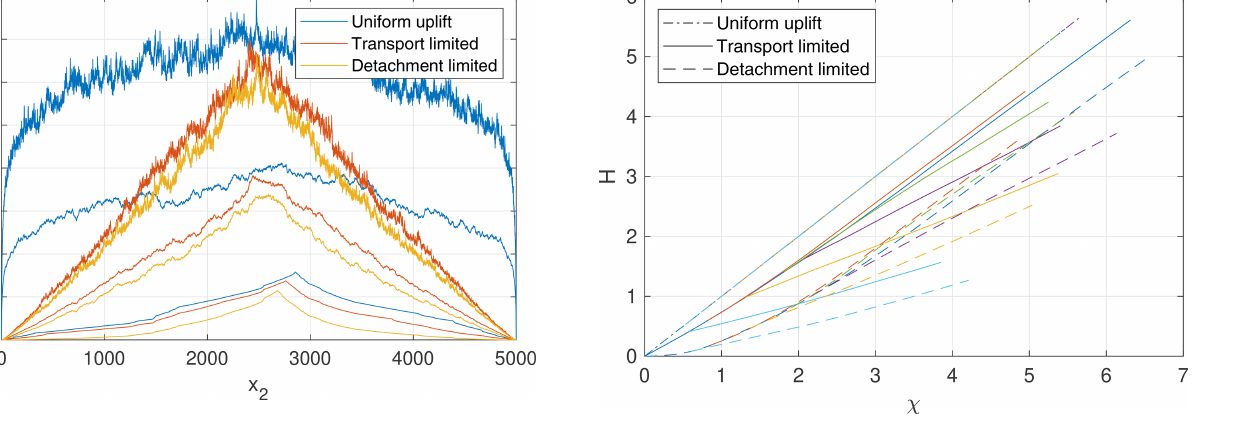
Figure 4. Longitudinal profiles of the rivers marked in Fig. 2 plot- ted in χ